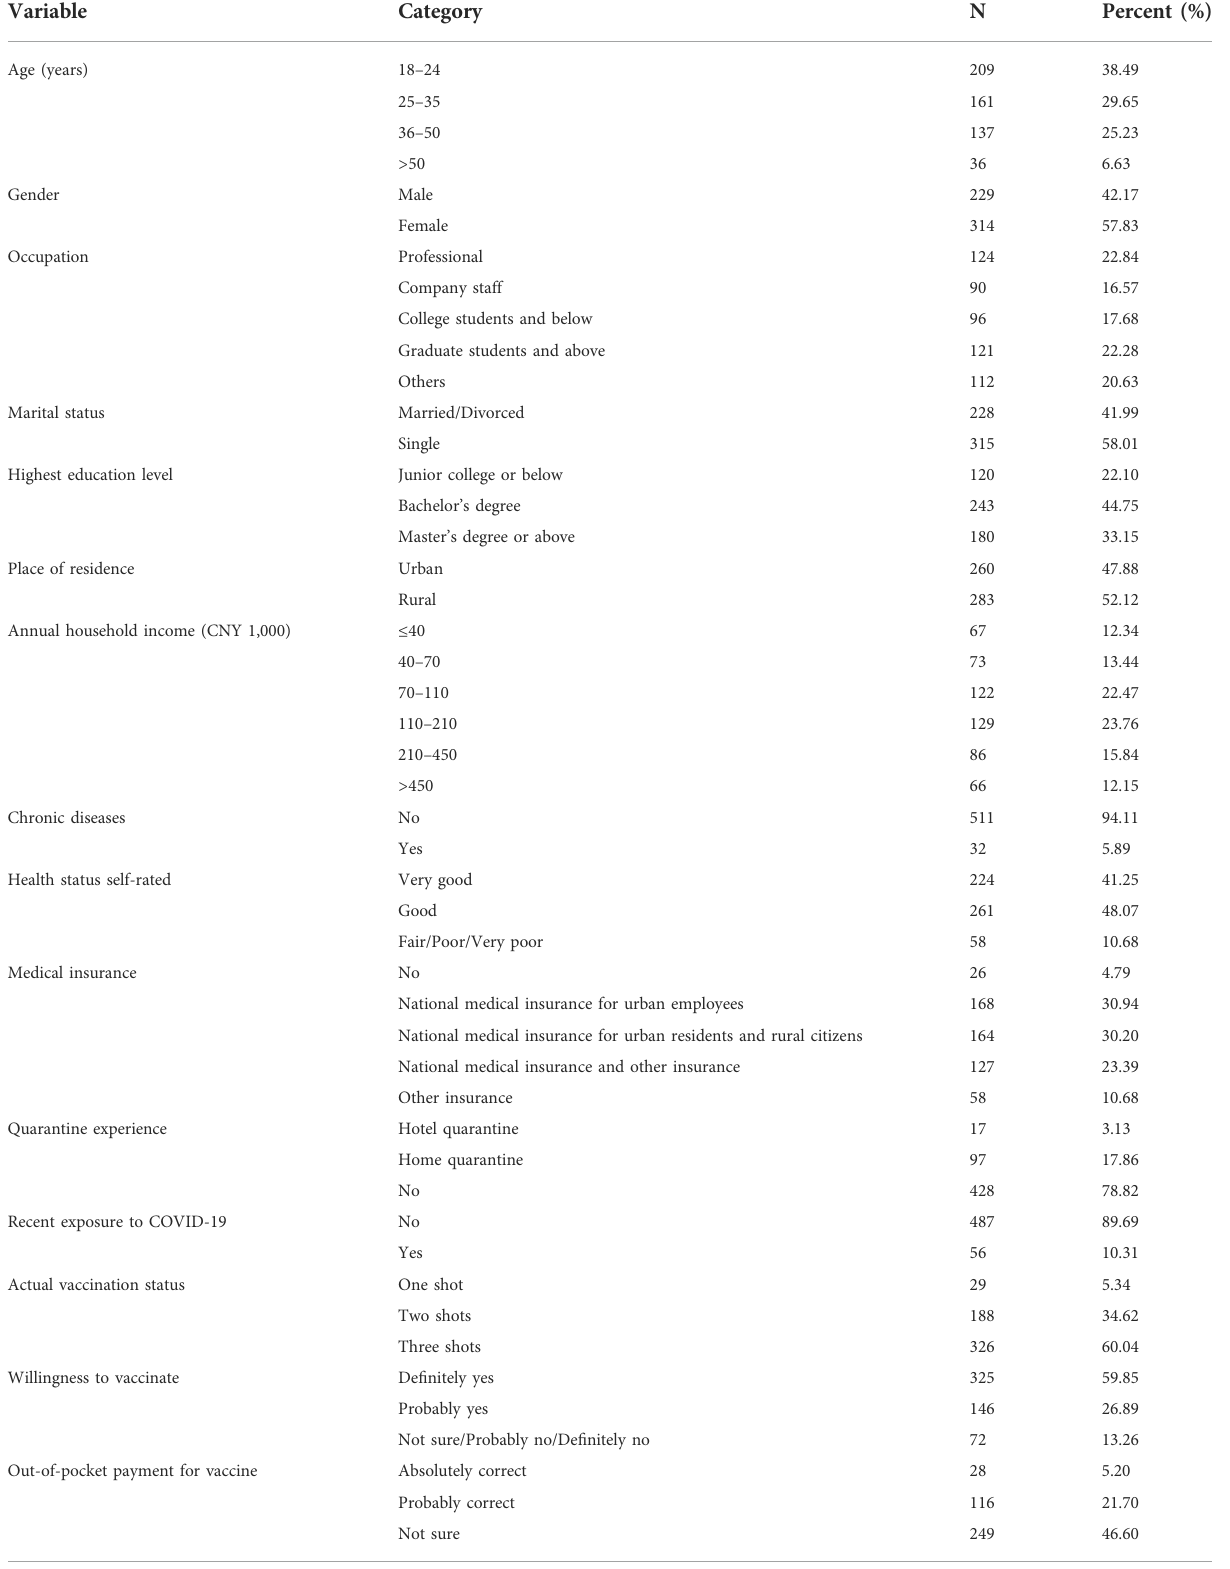
TABLE 1 Characteristics of study participants and willingness to